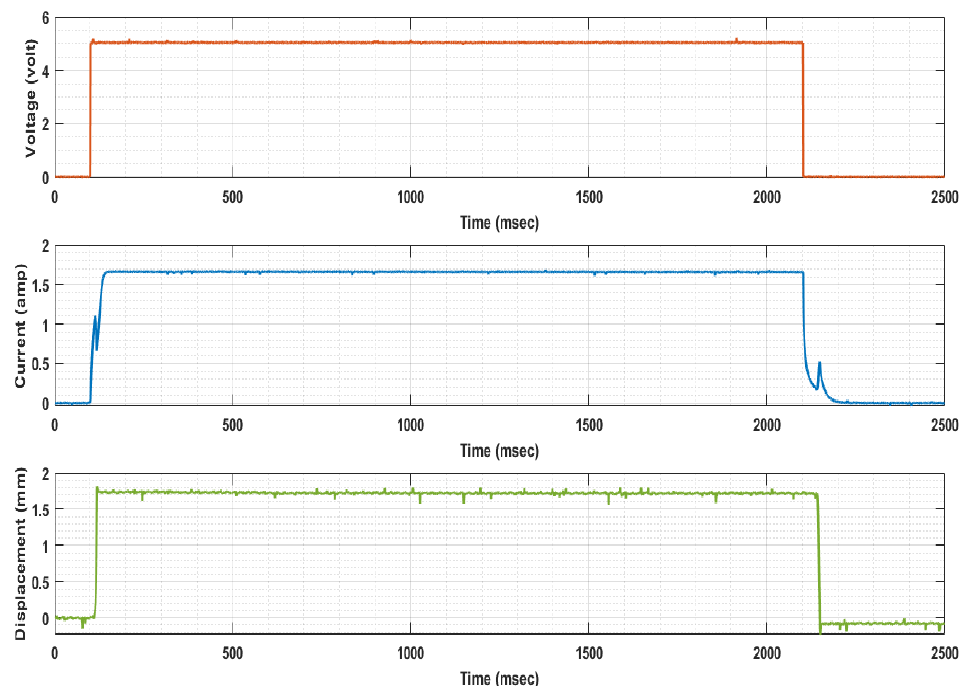
Figure 14 The solenoid exciting voltage and the corresponding solenoid coil current and valve spool displacement. The valve supply pressure equals 3